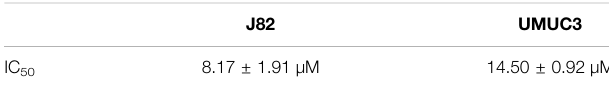
TABLE 1 | Inhibitory concentration 50% (IC 50 ) of